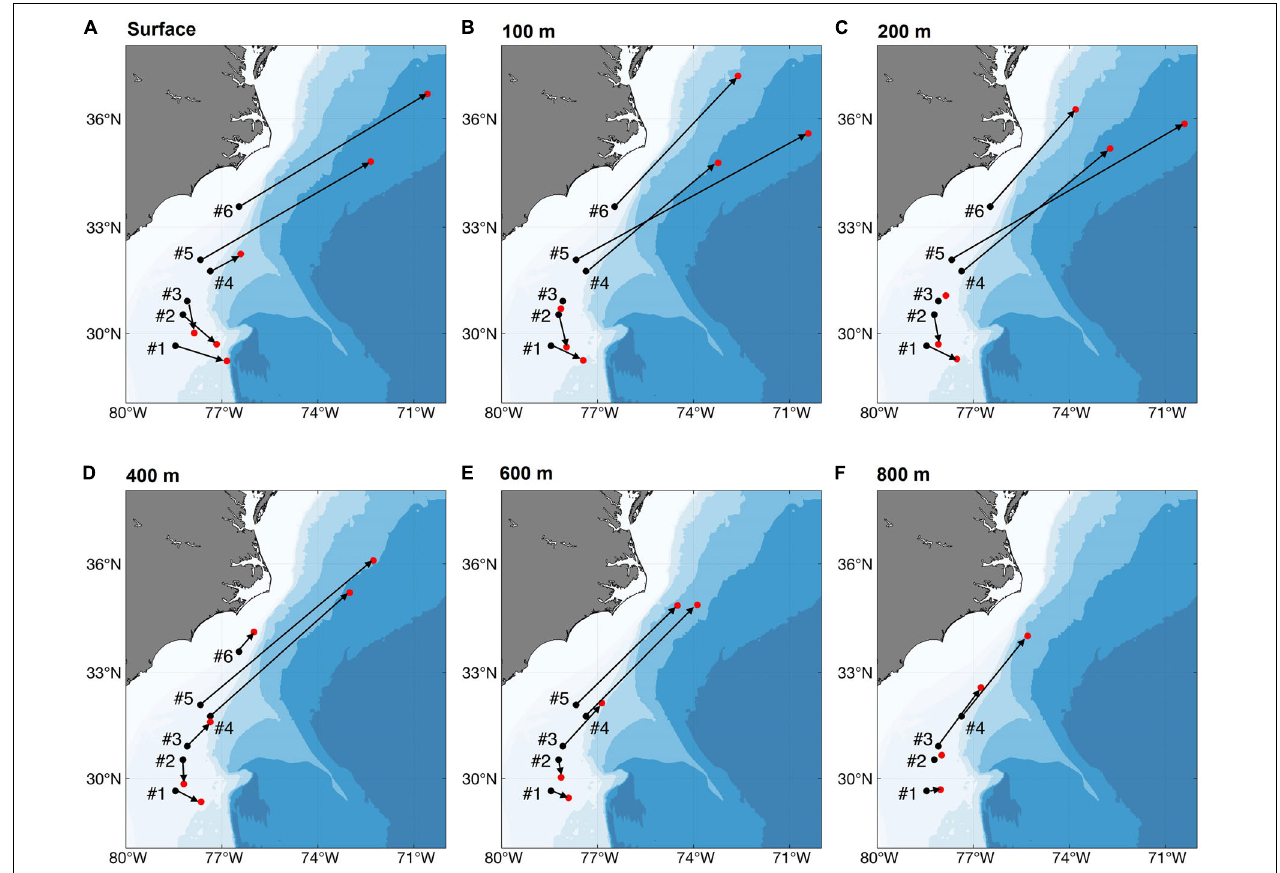
FIGURE 10 | Release positions (black dots), mean ending points (red dots) and net displacements of particles released within Group 4, north and south of Charleston Bump, at various release depths, using long-term averaged currents modeled with k h = 0. (A) Surface, (B) 100 m, (C) 200 m, (D) 400 m, (E) 600 m, and (F) 800 m. “#” denotes the individual occurrence record in Group